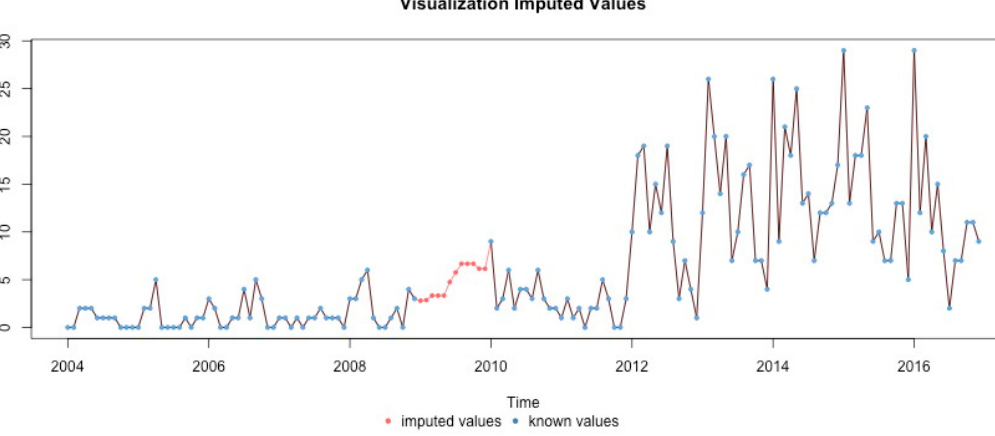
Figure A7. Precursor Czech nationals arrests 2004–2016 in the Czech Republic – imputed missing values.